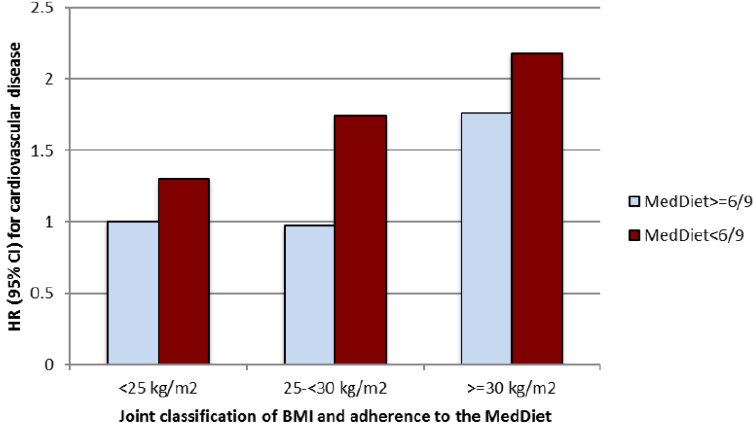
Figure 2. Relative risk of cardiovascular disease (HR and 95% confidence intervals) in the SUN project according to baseline body mass index and adherence to MedDiet.